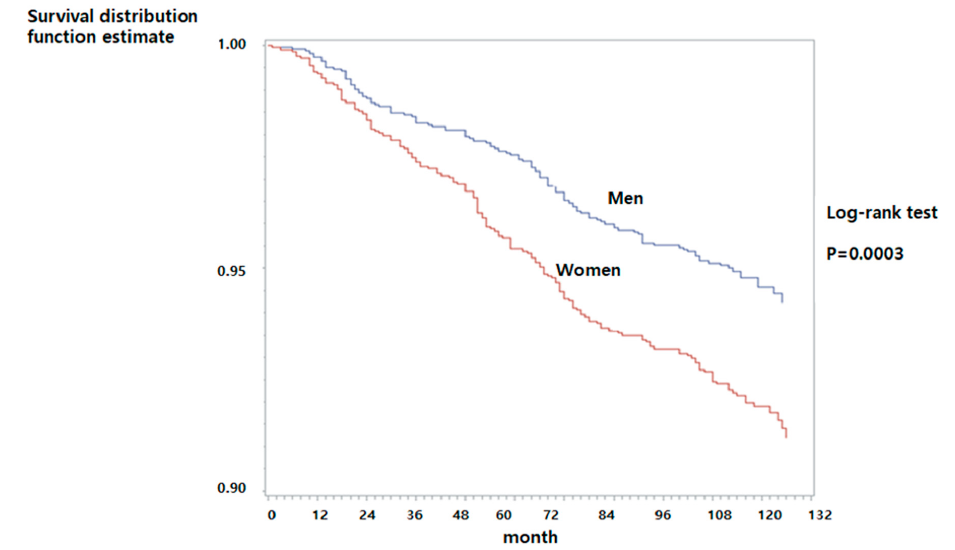
Figure 3. Survival curve for heart failure occurrence according to gender.